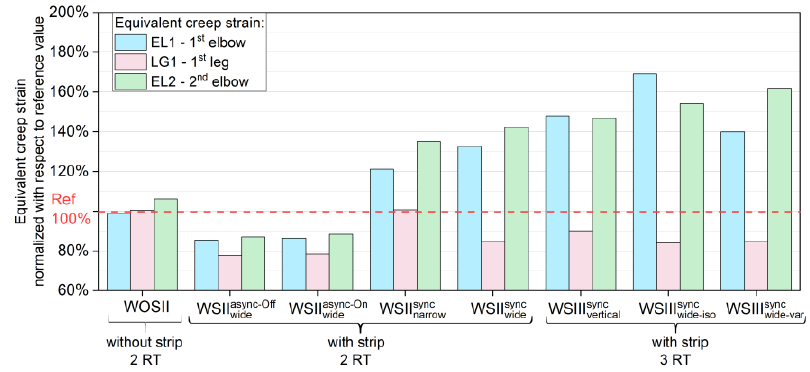
Figure 13. Creep strain at locations EL1 (= first elbow), LG1 (= first leg), and EL2 (= second elbow) after 400 h of process time for all nine cases.